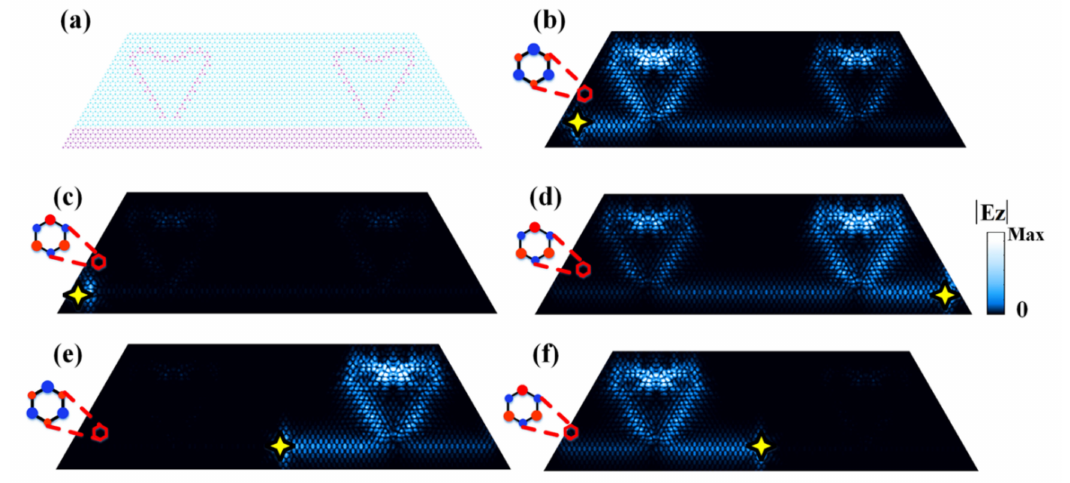
Figure 4. Versatile reconfigurable light imaging in a two-heart complex pattern with E 2 -edges as control ports. ( a ) Schematic of the two heart coding shapes that are connected to each other by an E 2